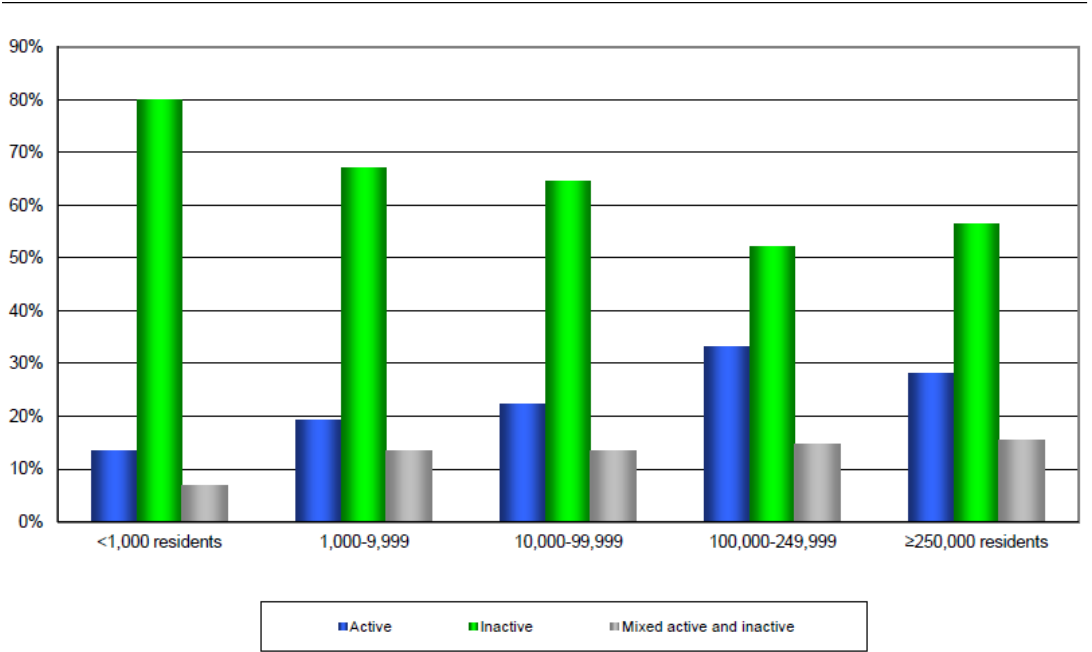
Figure 2. School travel mode used by Canadian children and youth stratified by community size.